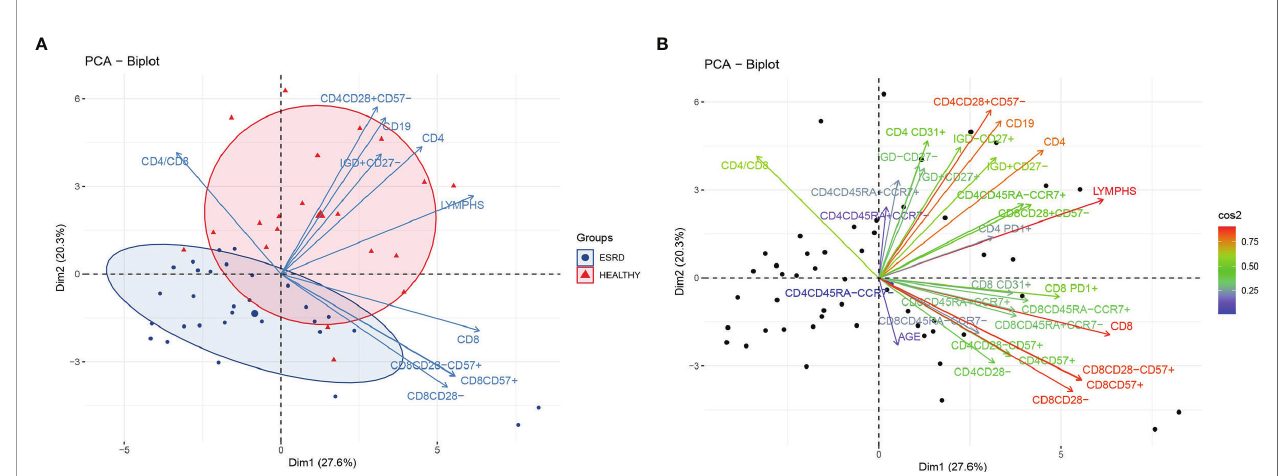
FIGURE 1 | (A) PCA biplot of immune senescence markers of ESRD patients and healthy controls, on a plane de fi ned by the fi rst two eigenvectors of the covariance matrix, separation of the two populations. Triangles represent healthy individuals and circles ESRD patients. Large symbols represent the centroid of each population and ellipses represent gaussian kernel density estimates for each class. Only the ten variables with the largest loadings are depicted. (B) PCA biplot of immune senescence markers of ESRD patients and healthy controls on a plane de fi ned by the fi rst two eigenvectors of the covariance matrix. Points represent individuals and arrows the corresponding variables. The color of each arrow is proportional to the cos2 of the explained variance according to the color vector on the right side of the fi gure.